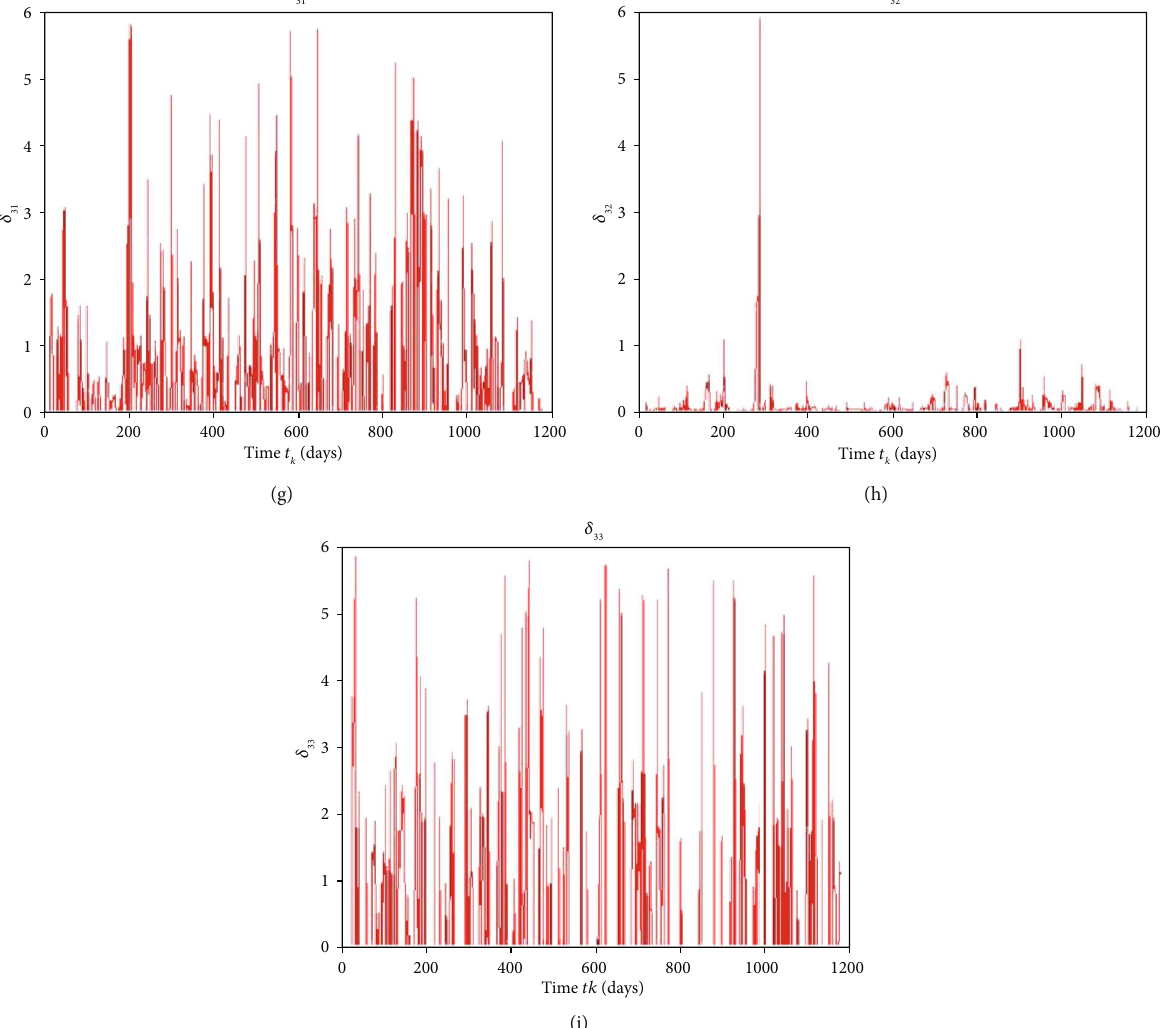
Figure 3: The graph of interaction coe ffi cients δ and δ